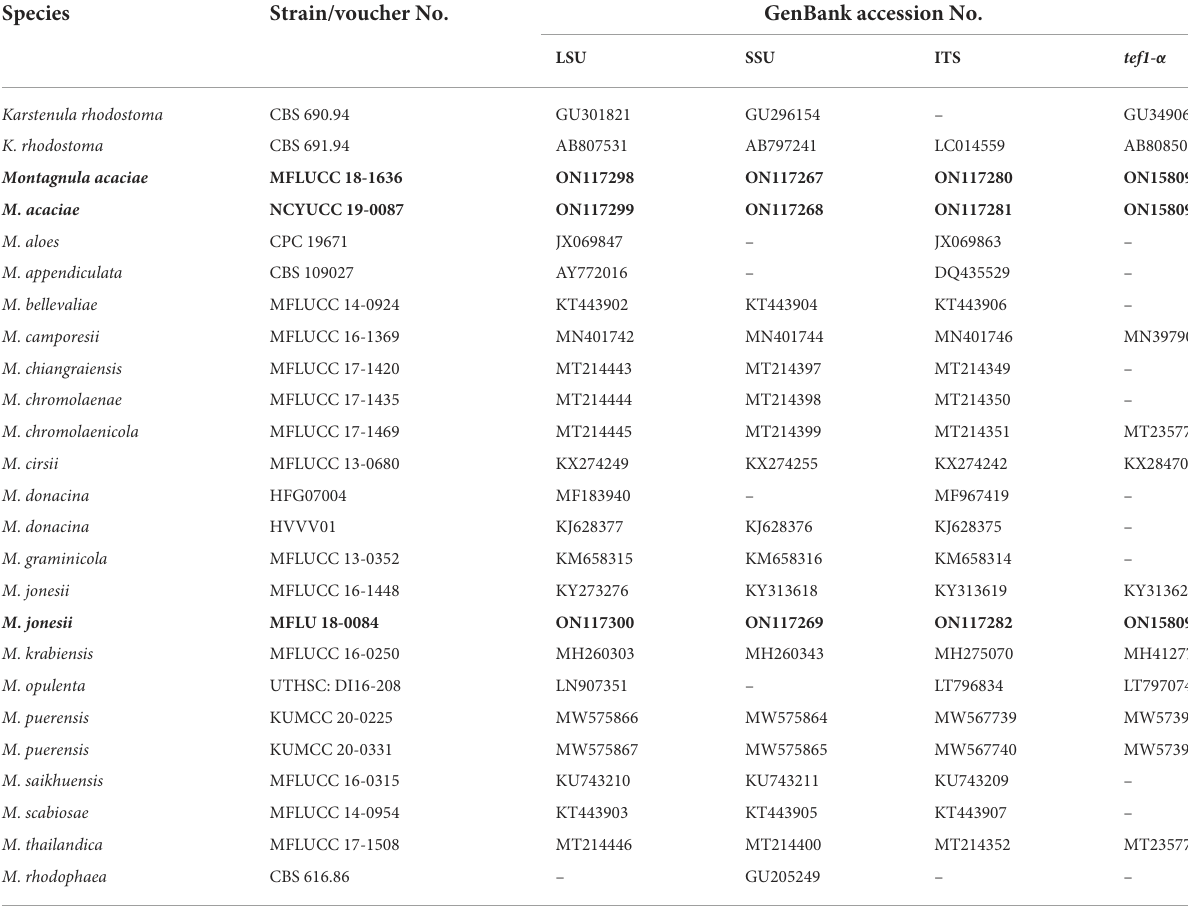
TABLE 1 GenBank and culture collection accession numbers of species included in this phylogenetic study ( Montagnula tree). Species Strain/voucher No. GenBank accession No. LSU SSU ITS tef1-